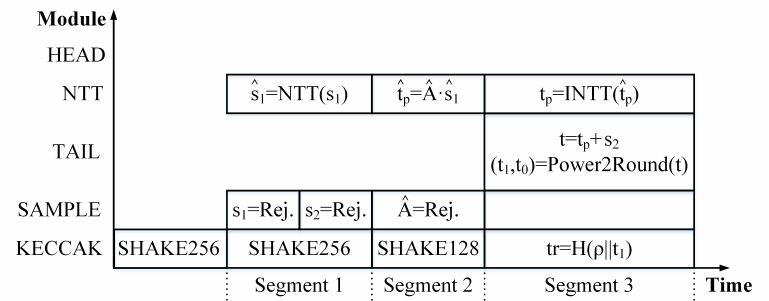
Figure 4: Segmented pipelined processing of KeyGen .